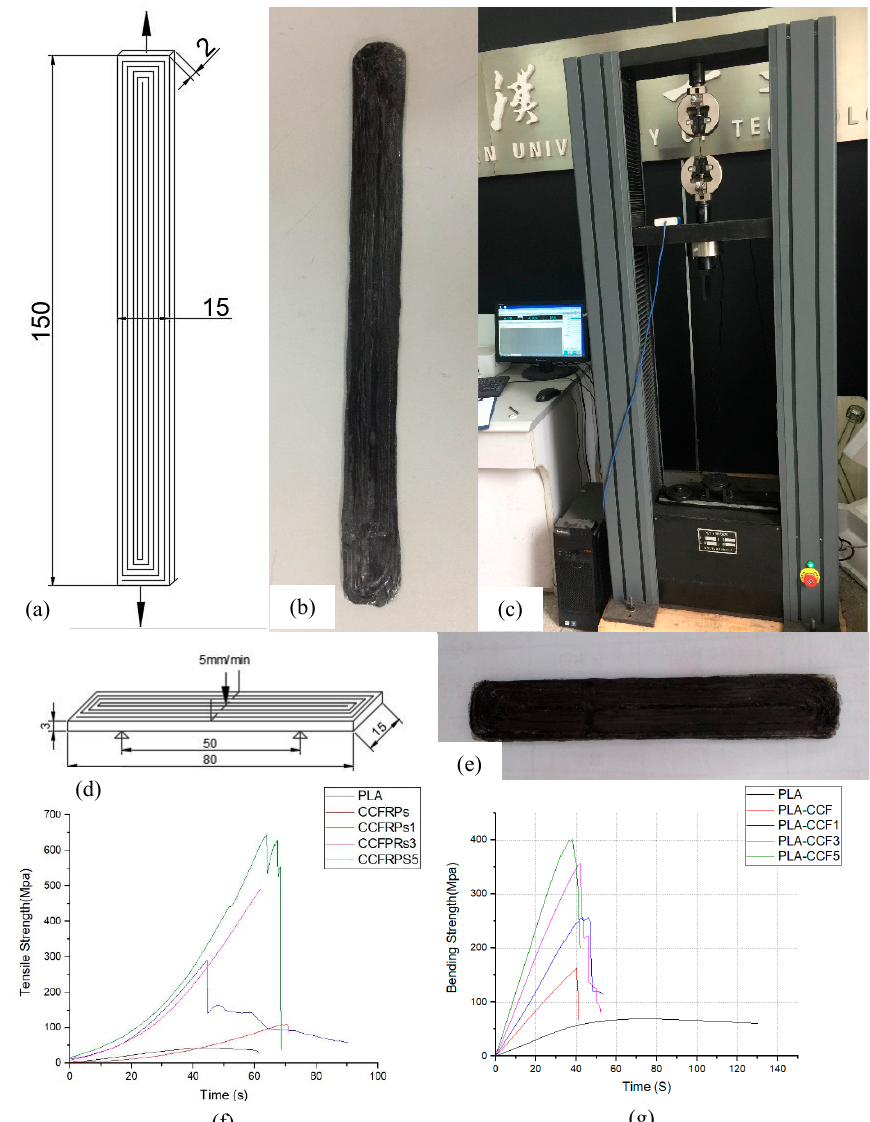
Figure 8. ( a ) The model of the tensile test (unit: mm), ( b ) the printed sample of the tensile test, ( c ) the test machine, ( d ) the model of the bending test, ( e ) the printed sample of the bending test, ( f ) the result of the tensile test, and ( g ) the result of the bending test.